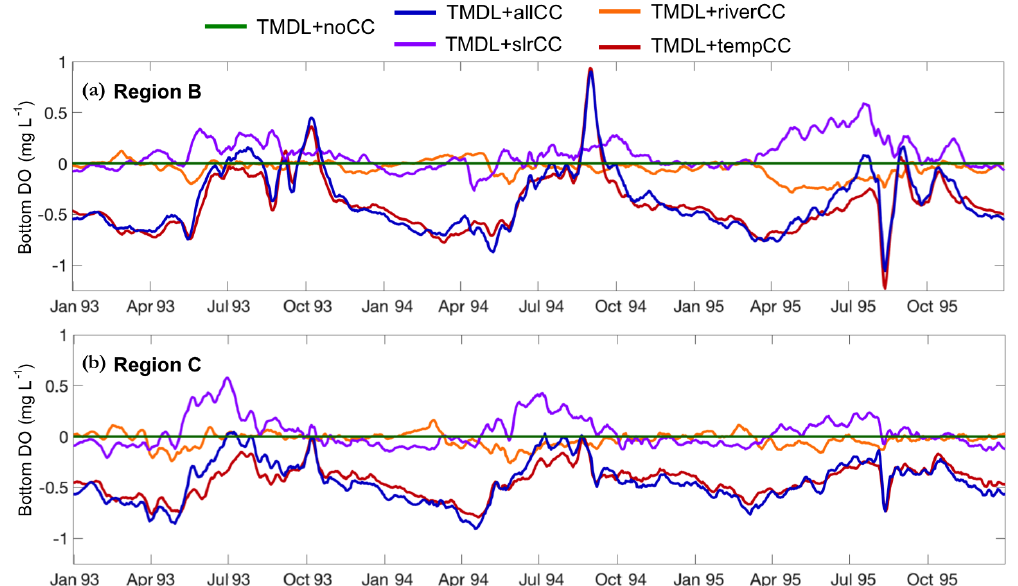
Figure 3. Time series (7-day running mean) of the change in bottom DO between the TMDL climate change and no climate change scenarios for the average of the (a) upper mesohaline Region B and (b) lower mesohaline Region C.